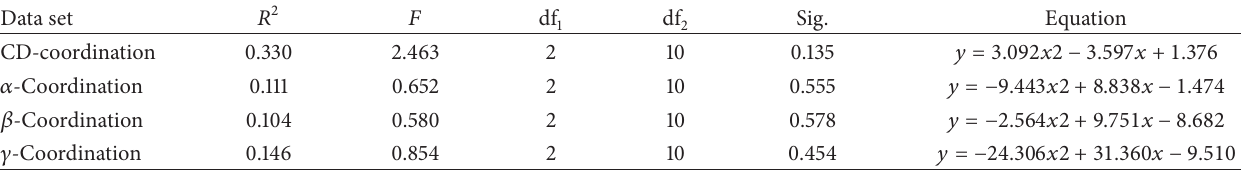
Table 5: Regression